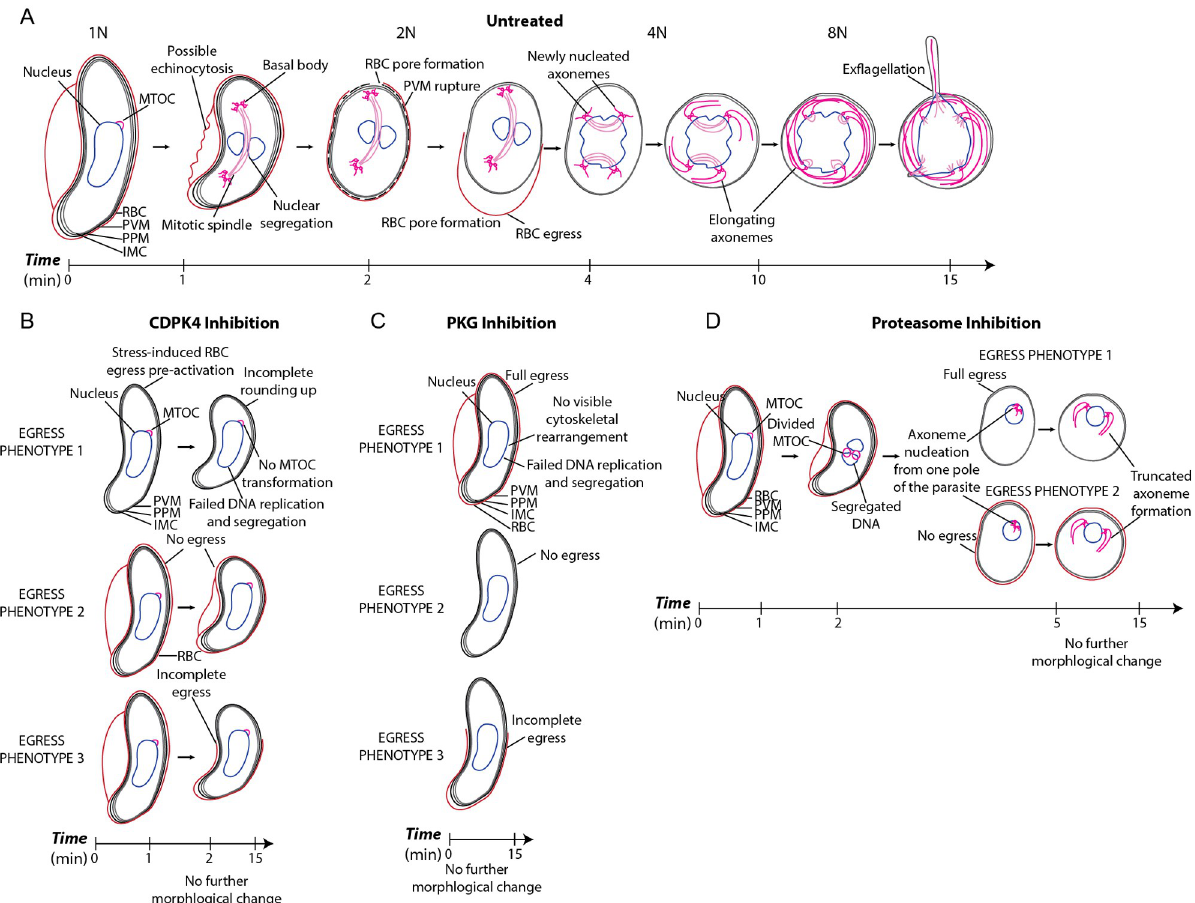
Fig 5. Novel insights into microgametogenesis with and without drug inhibition. Schematic diagrams showing the transformations observed by our live-cell microscopy of microgametogenesis. The observations depicted are of (A) untreated, (B) CDPK4-inhibited, (C) PKG-inhibited and proteasome-inhibited microgametocytes, treated with DMSO, 1294, ML10 and bortezomib, respectively. (A) Pore-formation and possible echinocytosis of the host cell membrane was found to occur during egress of untreated microgametocytes, which ejected from a single spindle pole of the parasite. Nuclear segregation was found to occur perpendicularly to the mitotic spindle. (B) CPDK4 inhibition prevented MTOC transformation and full rounding-up with three distinct egress phenotypes: 1) stress-induced egress prior to activation, 2) no egress and 3) incomplete egress. (C) Inhibition of PKG prevented rounding-up and any microtubule polymerisation, with 3 distinct egress phenotypes: 1) no egress, 2) full egress and 3) incomplete egress. (D) Proteasome inhibition resulted in abhorrent MTOC division and some nuclear segregation, with few truncated axonemes nucleating from one pole of the transformed parasite. Rounding-up of proteasome-inhibited parasites was observed.